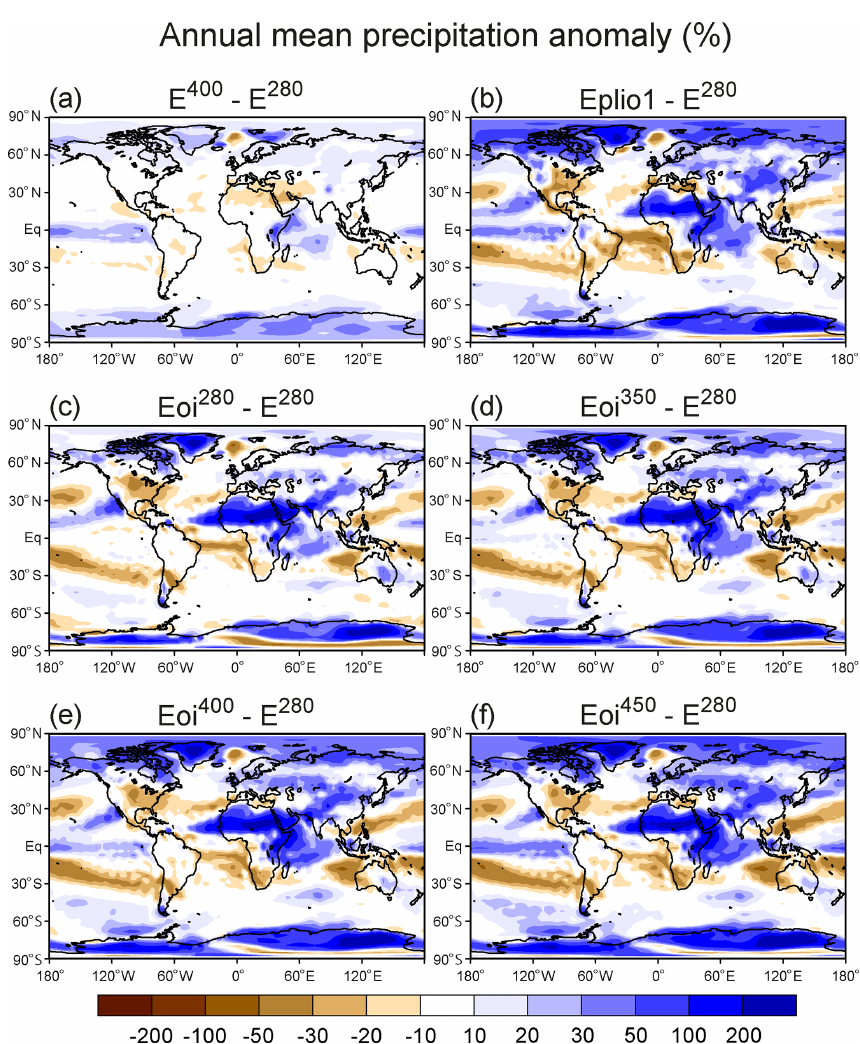
Figure 7. Annual mean precipitation anomaly between six experiments and E 280 , the pre-industrial one, as a percentage of E 280 , e.g. 100 × (Eoi 400 − E 280 ) / E 280 . For a comparison of PlioMIP1 and PlioMIP2, see (b, e) . For the individual effects of CO 2 and Pliocene boundary conditions, see (a, c) ,